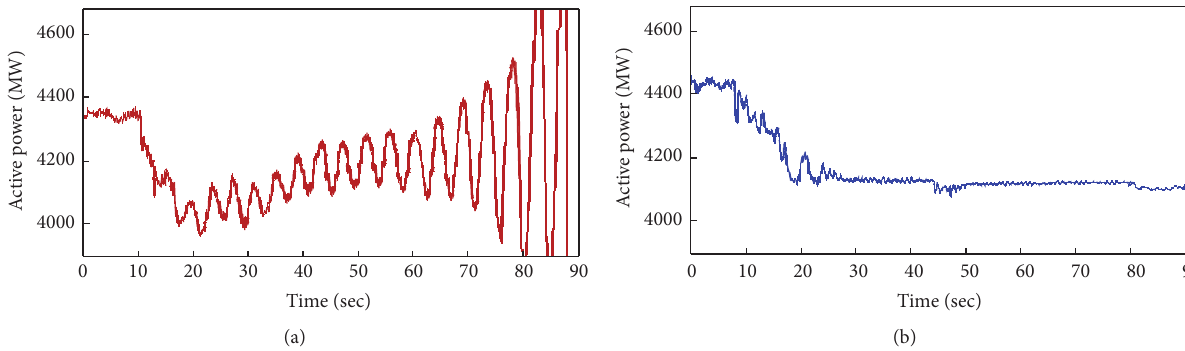
Figure 1: The event of the small-signal instability during the blackout WSCC system on Aug. 10, 1996: (a) the observed California Oregon Interconnections power (Dittmer control center); (b) the simulated California Oregon Interconnections power (initial base